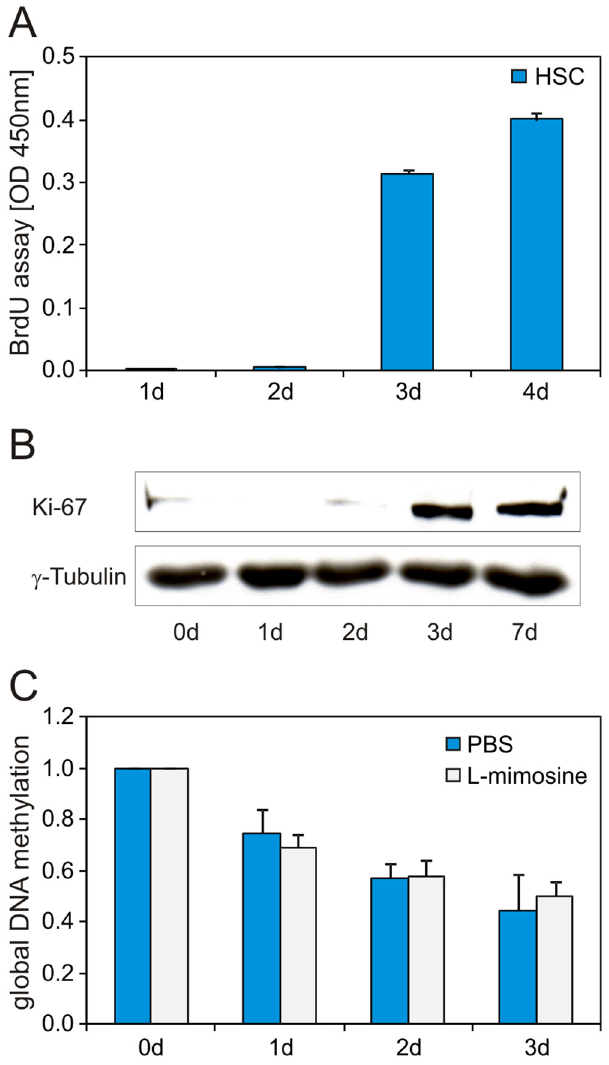
Fig 5. Global DNA demethylation during early HSC activation is due to an active mechanism. (A) BrdU assay during HSC culture showed that DNA synthesis in HSC was absent during the first two days of culture. (B) In line with this, the Ki67 western blot revealed that freshly isolated HSC were in the G0-phase and entered the cell cycle at the third day of culture. (C) L-mimosine treated HSC showed global DNA demethylation during culture with no significant difference to control treated cells (n = 3 independent experiments). Thus DNA demethylation was independent of DNA synthesis implicating an active mechanism. Global DNA methylation was determined by a 5meC